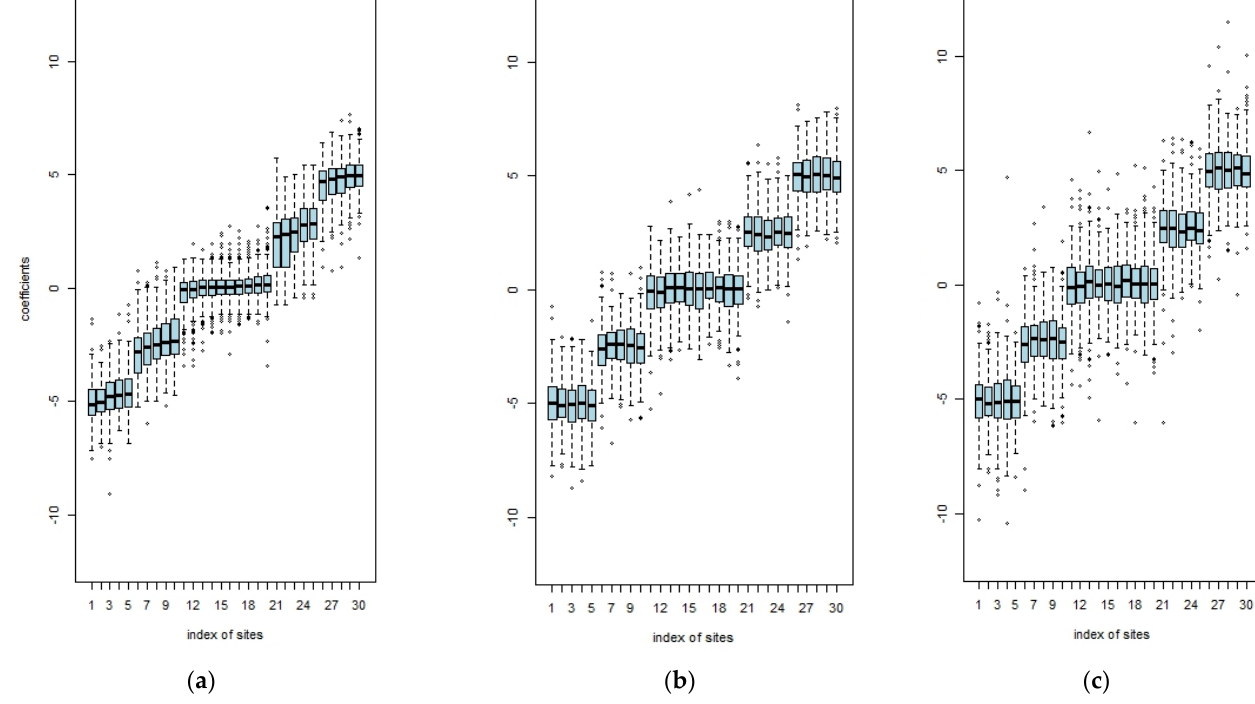
Figure 5. Estimated coefficients of the proposed method ( a ), rLSE ( b ) and rLAD ( c ) in simulation 2.